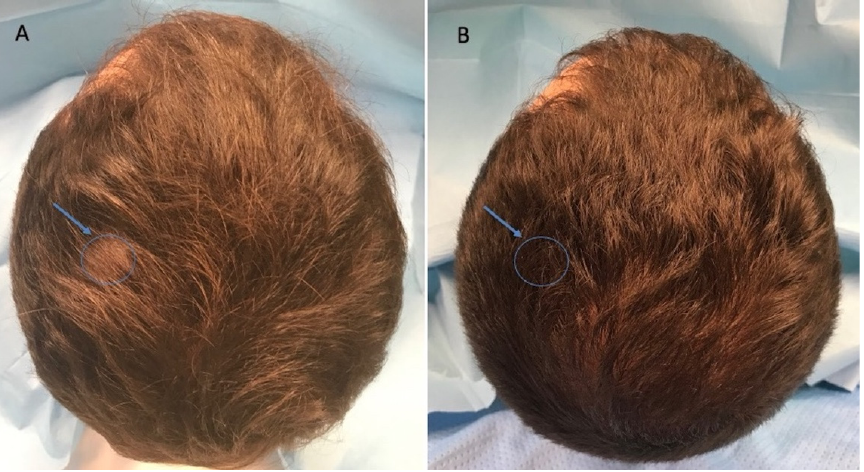
Figure 3. Caucasian male patient treated with LLLT, MND, and GFs protocol. ( A ) Pre-operative